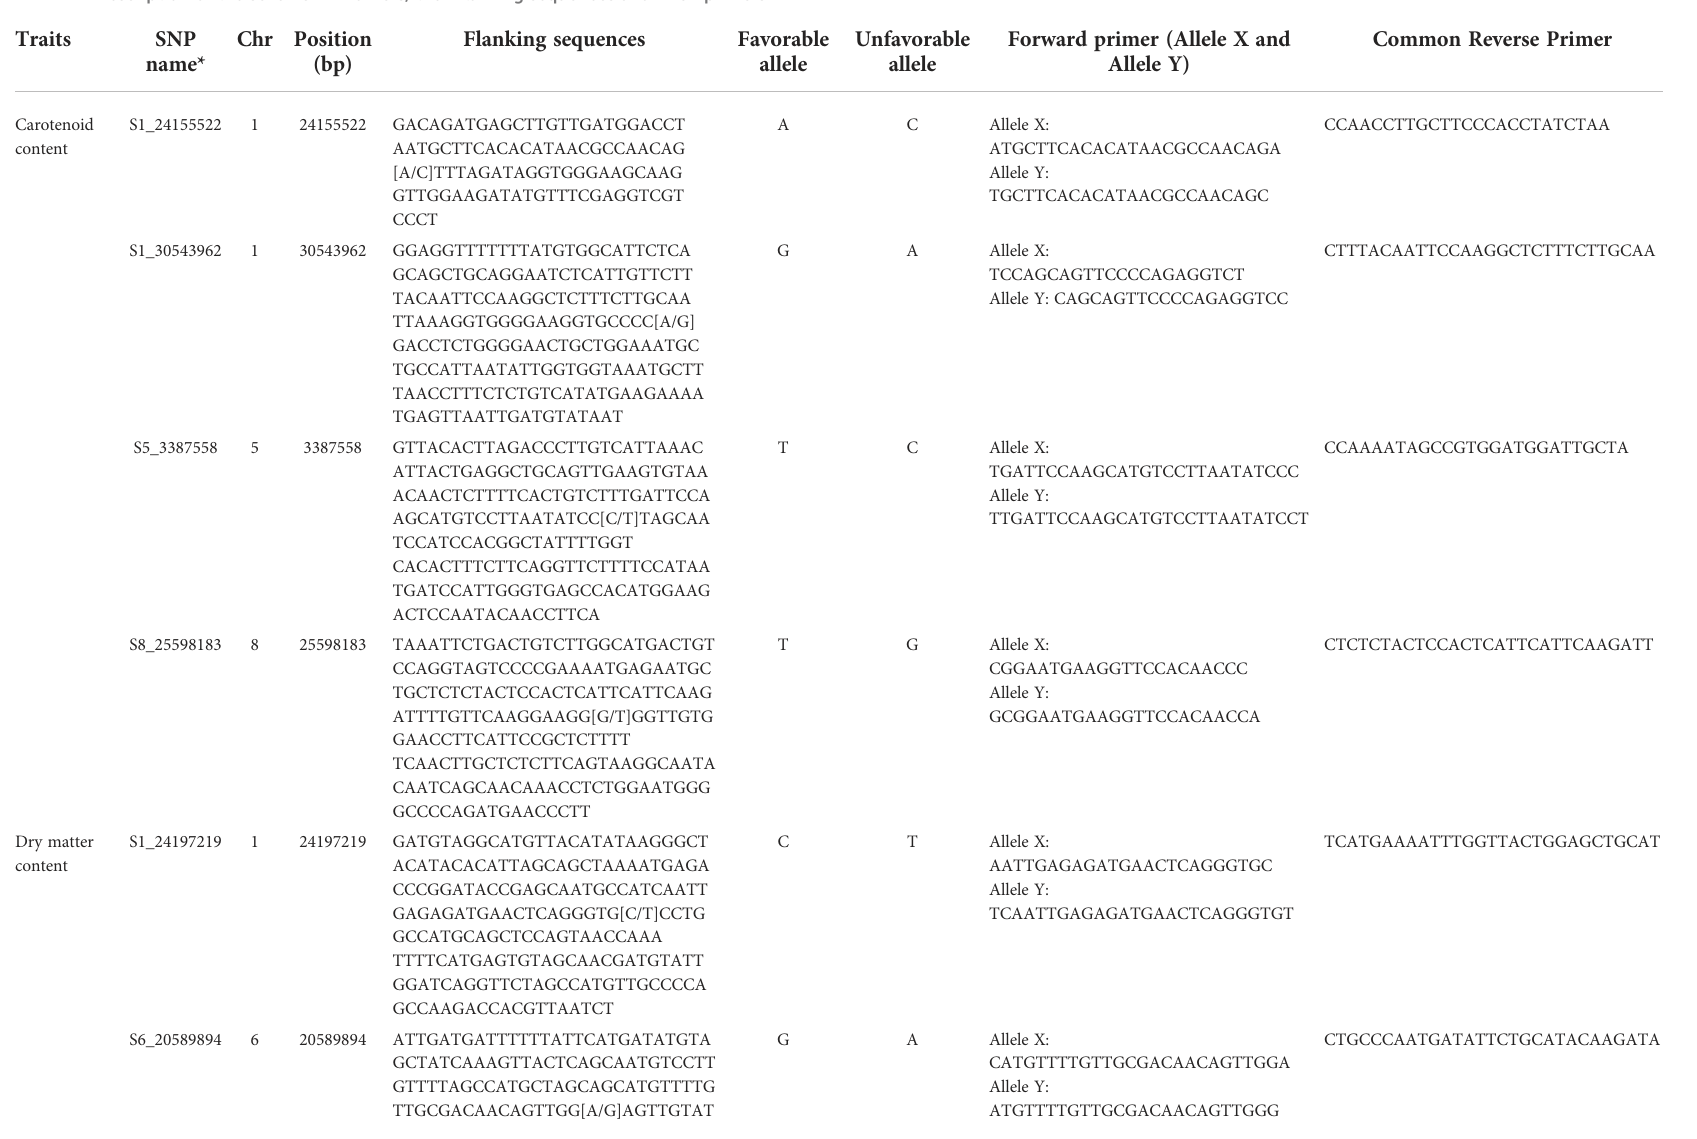
TABLE 1 Description of the seven SNP markers, their fl anking sequences and KASP primers.